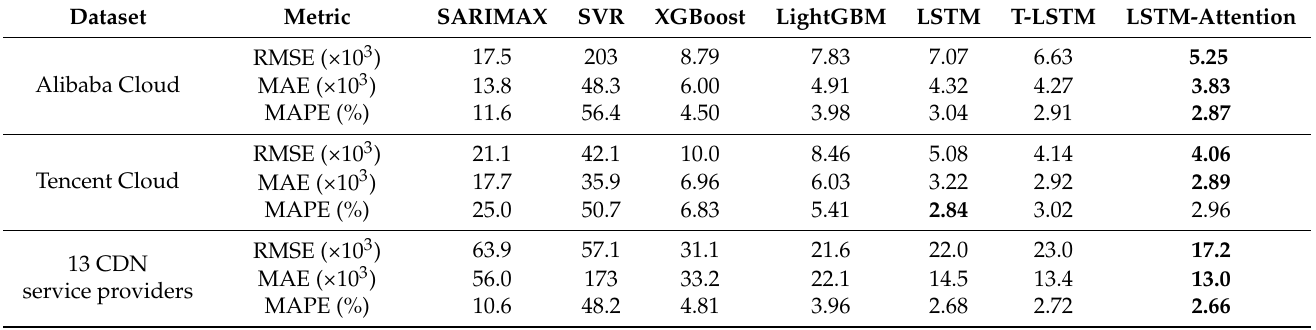
Table 2. Prediction results of the three prediction datasets with different metrics and